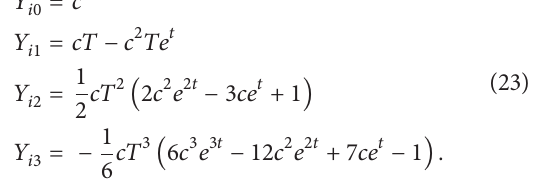
Figure 3: Comparison of the ode45 and the EMHPM numerical integration